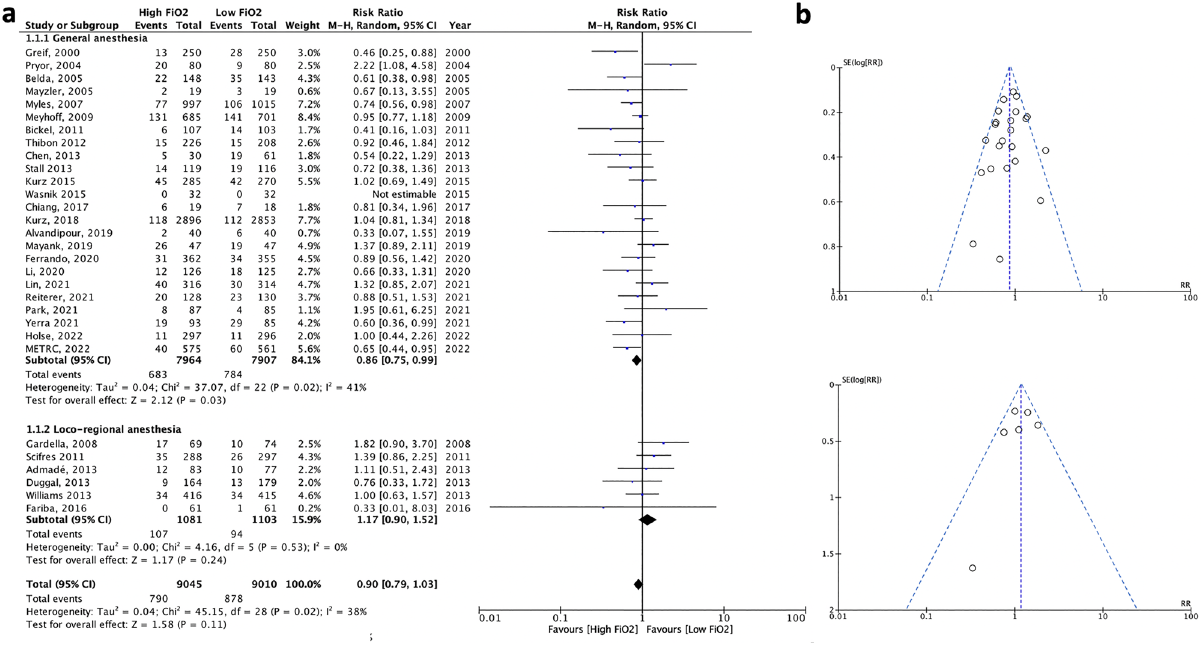
Figure 3. Forest plot analysis of high vs. low intraoperative FiO 2 on the incidence of SSI ( a ), within the subgroups of patients operated under general anesthesia and loco-regional anesthesia; and corresponding funnel plots ( b ). The X-axis of forest plots represents relative risk, and each row on the Y-axis represents an individual study. The blue squares and horizontal lines represent point estimates and corresponding 95% confidence intervals of the individual studies. The black diamonds represent the overall